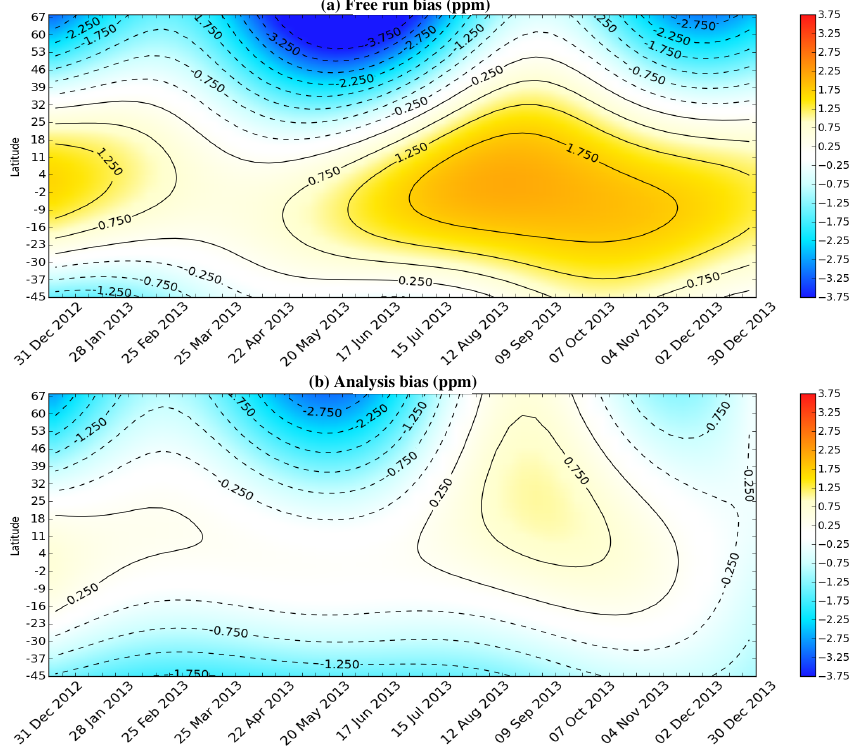
Figure 2. Hovmöller diagram (latitude vs. time) of the smoothed bias (in ppm, negative/positive in blue/red) of the simulated XCO 2 against the data of the TCCON network, from 1 January to 31 December 2013. (a) Free-run simulation. (b)